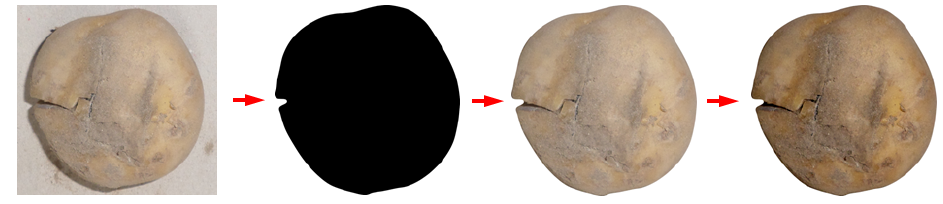
Figure 2. Image processing scheme (source: own materials).